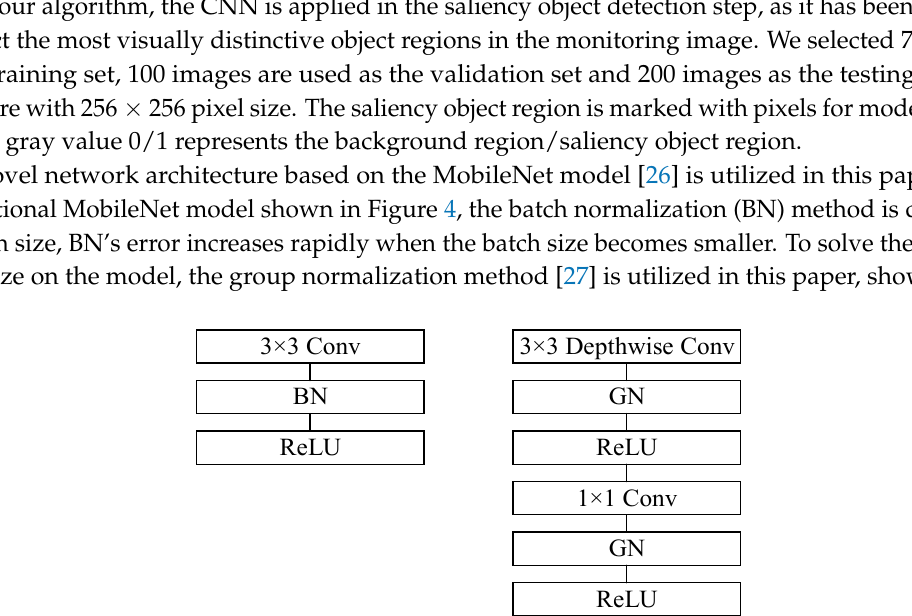
Figure 5. Skip layer short connections in network architecture. In the network architecture, the side loss function and fusion loss function are calculated as ~